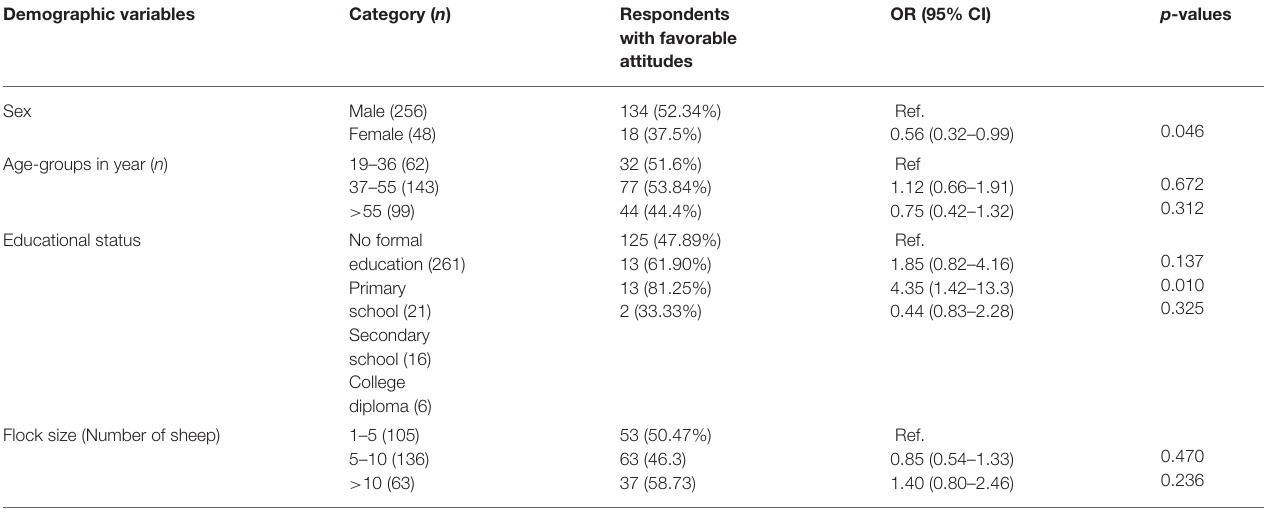
TABLE 9 | Association of demographic variables with attitudes of respondents toward ovine pasteurellosis ( n = 304).